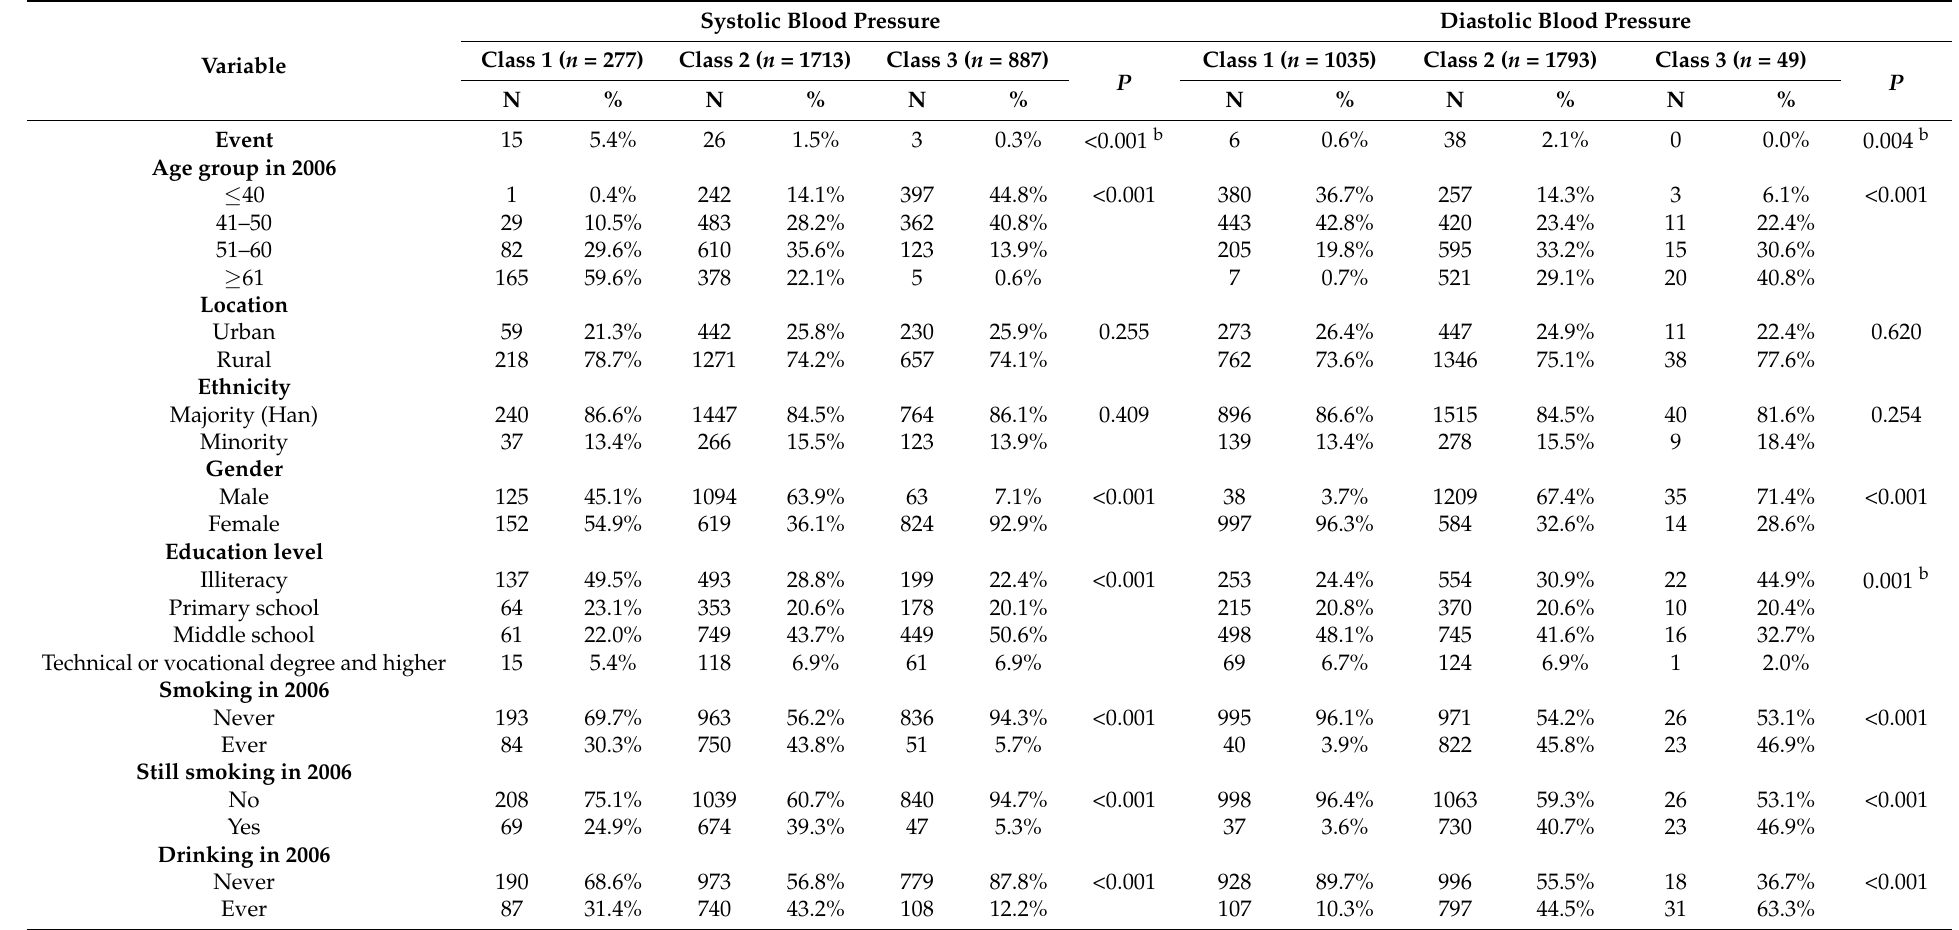
Table 2. The characteristics across blood pressure trajectory groups (systolic pressure and diastolic pressure, respectively) in the dataset of stroke ( N =